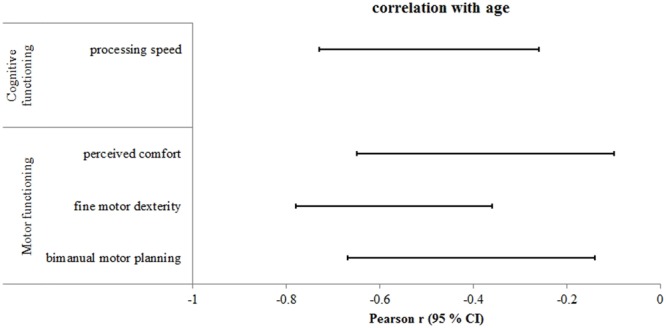
Statistically significant correlations between age and cognitive-motor function measures within the group of older adults. Displayed are the 95% confidence intervals (CI) of the Pearson correlation coefficient (r) adjusted for sample size. Negative correlations indicate a decline of the respective cognitive or motor function with increasing age.